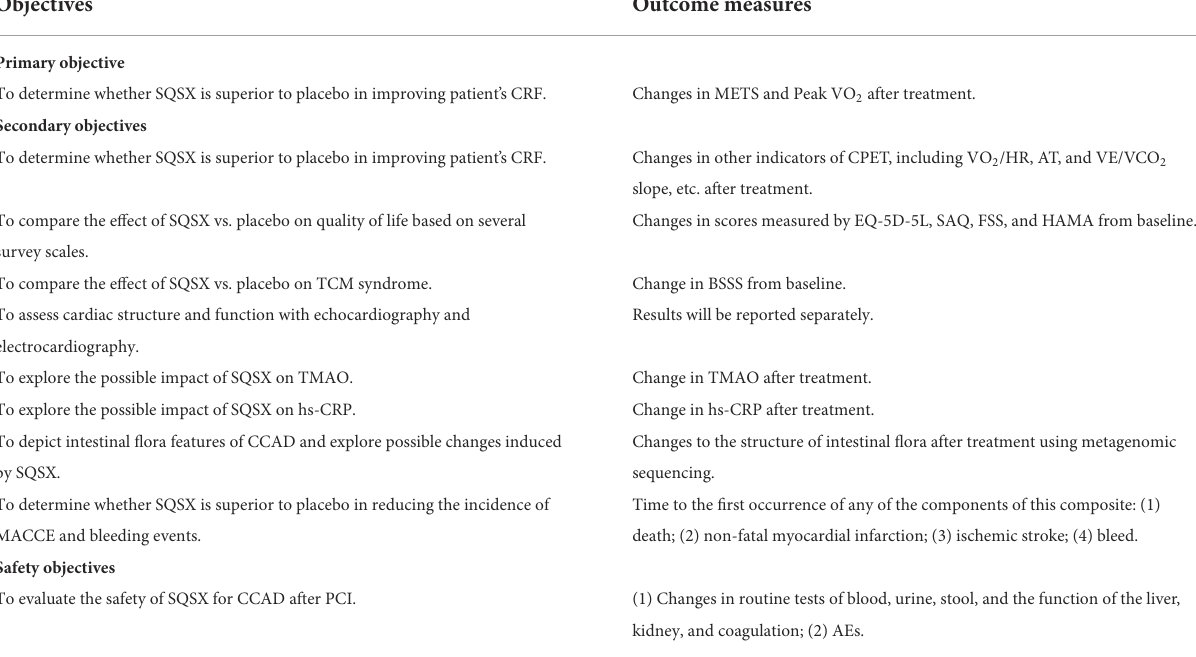
TABLE 3 Primary, secondary and safety